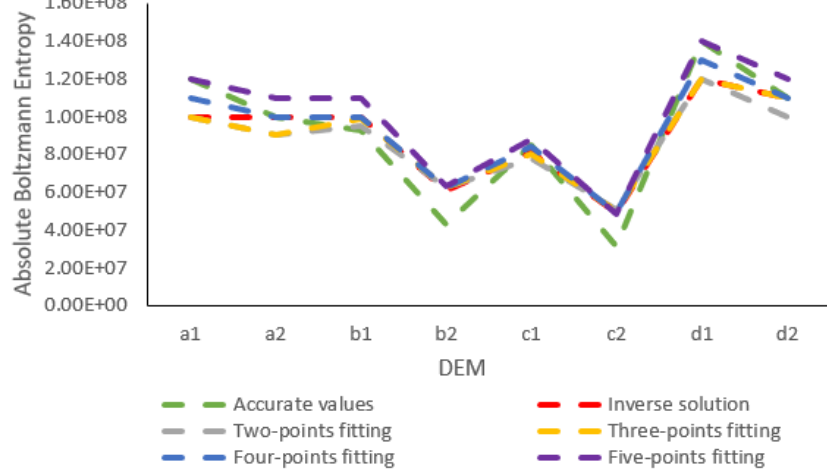
Figure 7. A comparison of the absolute Boltzmann entropies of four pairs of DEMs from accurate values and estimates produced by five methods.